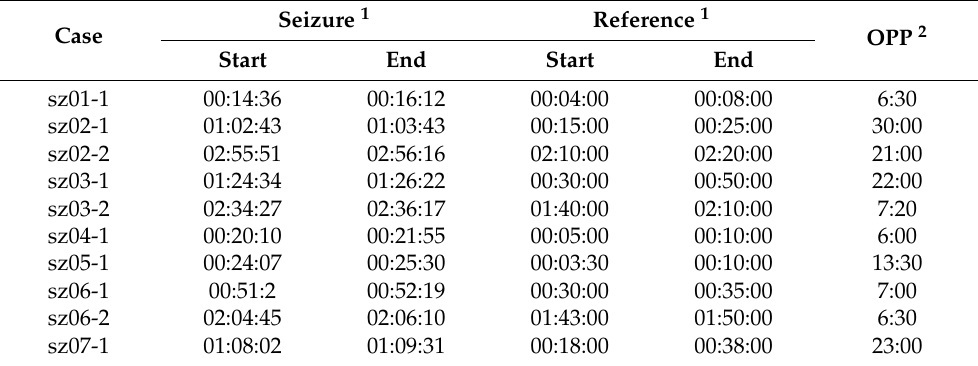
Table 2. Recording seizure ictal, reference intervals and selected OPP for each case.